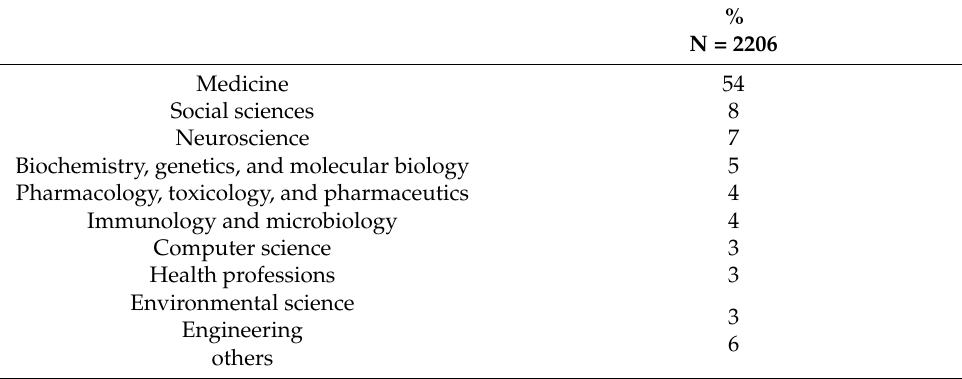
Table 2. Classification according to thematic